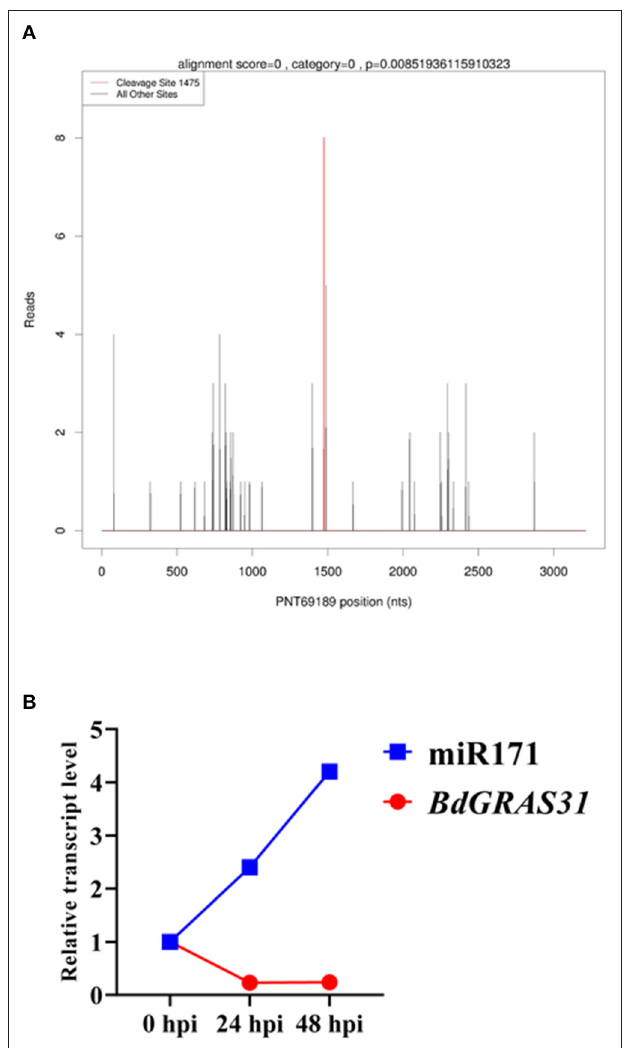
FIGURE 6 | BdGRAS31 is the target gene of miR171. (A) Identification of BdGRAS31 was the target of Bd-miR171 by degradome sequencing. (B) The expression of miR171 and BdGRAS31 in Brachypodium distachyon after inoculation with M. oryzae .